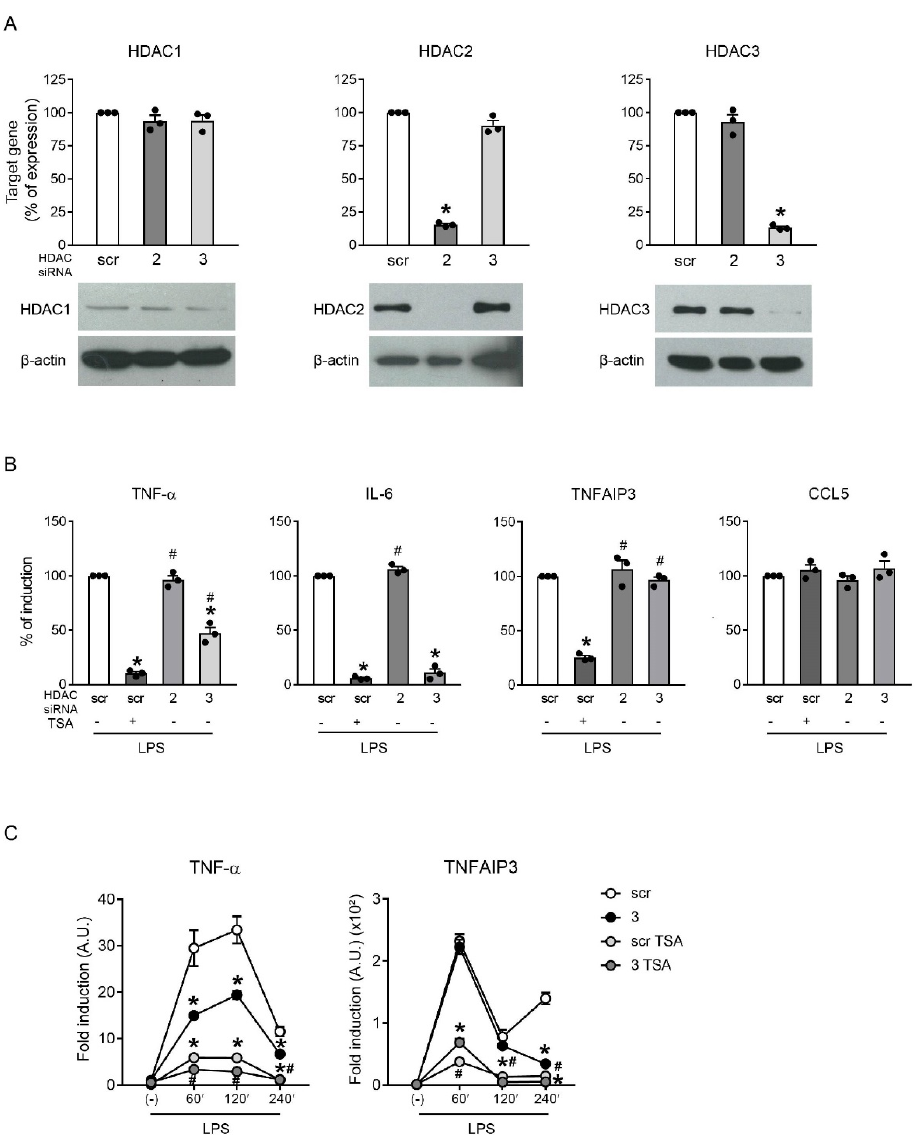
Figure 4. HDAC3 knockdown partially recapitulated the effects of TSA. ( A ) RAW246.7 cells were transfected with the indicated siRNAs: target gene expression was evaluated using qPCR (upper panels) and expression at the protein level using Western blot analysis (lower panels). The results depict the percentage of target gene expression (mean ± SEM, n = 3) (upper panels) and a representative Western blot experiment; scr: scramble. Dots represent results of individual experiments. ( B ) siRNA-transfected RAW246.7 cells were treated with 1 µg/mL LPS for 60 min prior to mRNA extraction. The expression of TNF- α , IL-6, TNFAIP3 and CCL5 was investigated at the mRNA level using RT-PCR. Data were normalized to the housekeeping RNA (18S) and expressed as the mean ± SEM ( n = 3) of the percentage of production in scr cells stimulated with LPS alone. As a comparison, cells transfected with scramble siRNA were also pre-treated with 100 ng/mL TSA. * p < 0.05 versus scr using an unpaired t -test; # p < 0.05 versus scr TSA using one-way ANOVA with Dunnett’s post hoc test. Dots represent results of individual experiments. ( C ) RAW246.7 cells transfected with scr or HDAC3 siRNA were treated with 1 µg/mL LPS for 60, 120 and 240 min with or without a 100 ng/mL TSA pre-treatment prior to mRNA extraction. The expression of TNF- α and TNFAIP3 was investigated at the mRNA level using RT-PCR. Data are normalized to the housekeeping RNA (18S) and expressed as the mean ± SEM ( n = 3) of 2 −ΔΔ Ct relative to (-). * p < 0.05 versus respective scr or # p < 0.05 versus respective HDAC3 siRNA using an unpaired t -test.